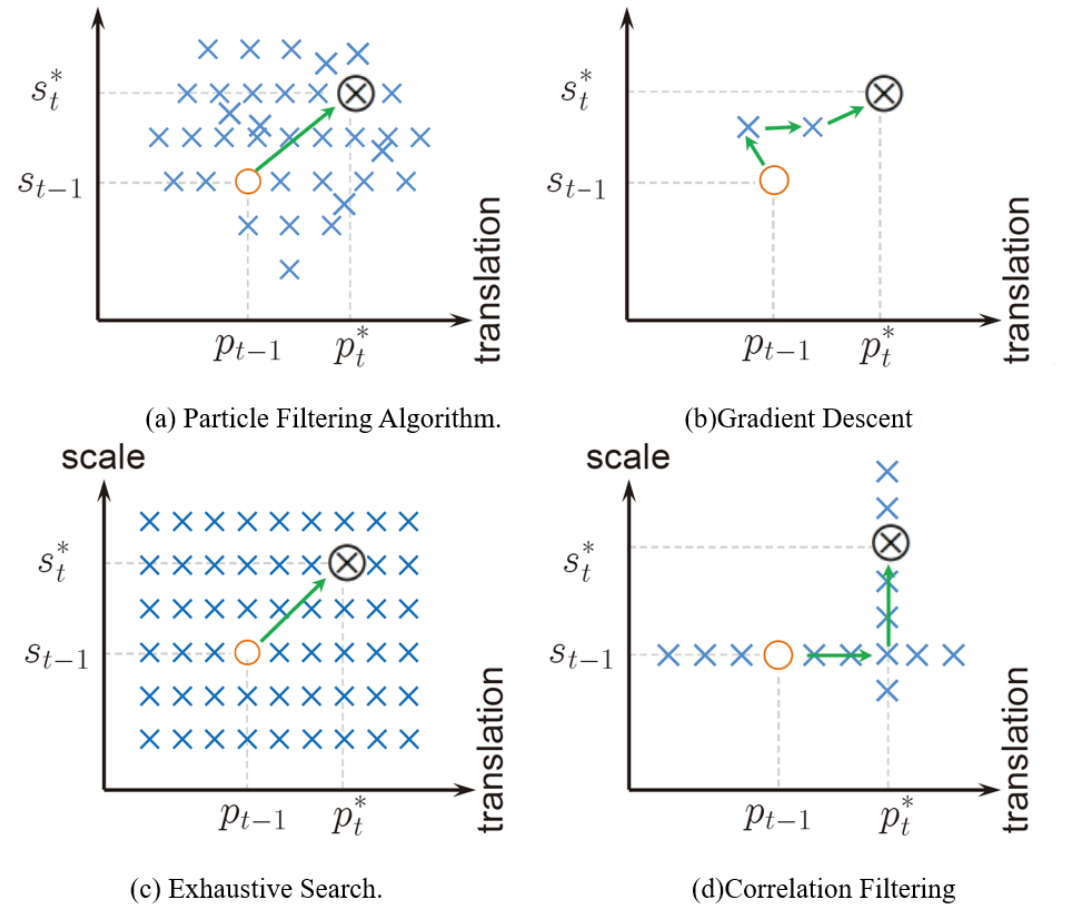
Figure 4. Illustration of common state estimation methods in object tracking. Symbols O, × and ⊗ denote the current, sampled and optimal states,